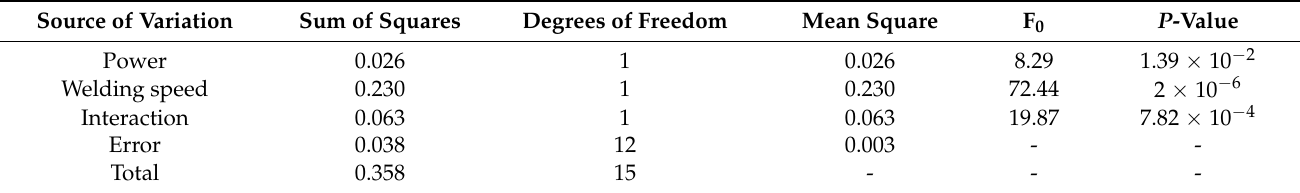
( b ) Figure 11. ( a ) Interaction in the factorial experiment; ( b ) width W in the function of the Heat Input. Figure 11b also includes the widths W corresponding to the five samples of the S5 series and considering the width W of the S4 series with the widths W of the S5 series due to the fact that the two series did not achieve full penetration with a single pass weld, it is verified that for both complete penetration and partial penetration there is an approxi- mately linear relationship between width W and HI. Lastly, since it was tested that the